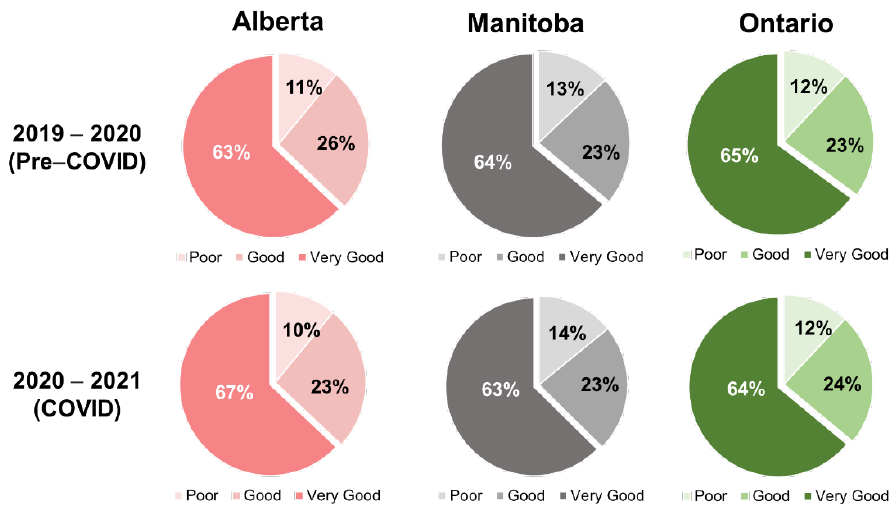
Figure 4. Patient survey rating hospital service experiences through